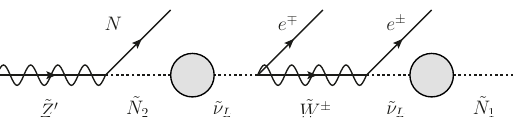
Figure 2. Possible cascade decay of ~ Z 0 via the mixing of left and right-handed sneutrinos. and a dark matter candidate [6]. The wino-like chargino ~ (cid:31) (cid:6)